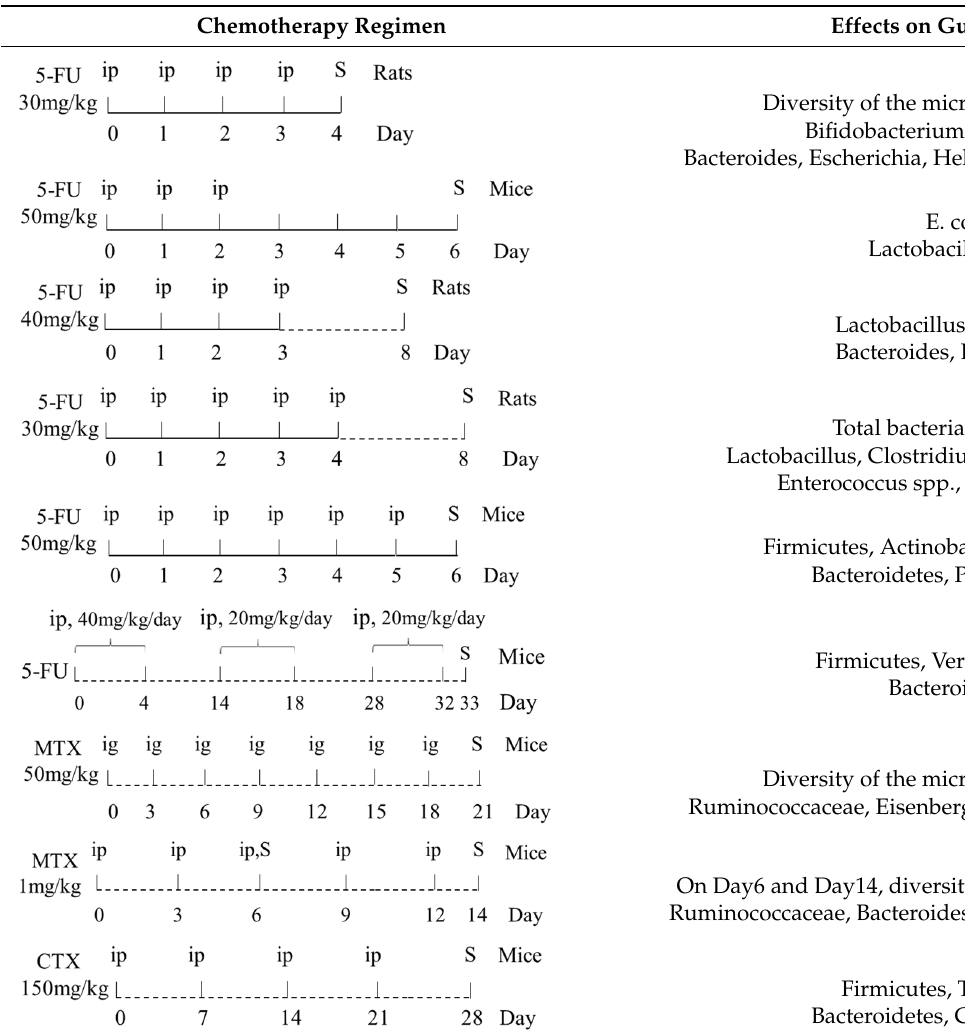
Table 1. Effects of different chemotherapeutic regimens on intestinal microbiota in animal